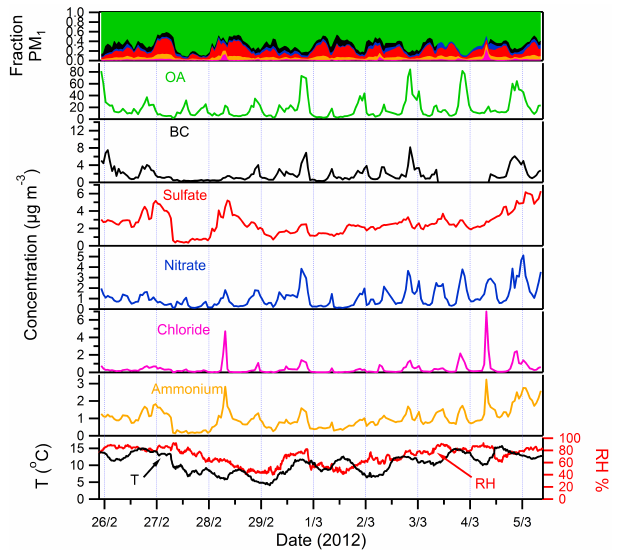
Figure 1. Fractional contribution and time series (hourly averages) of the main PM 1 species during the Patras campaign. Also shown are the temperature and